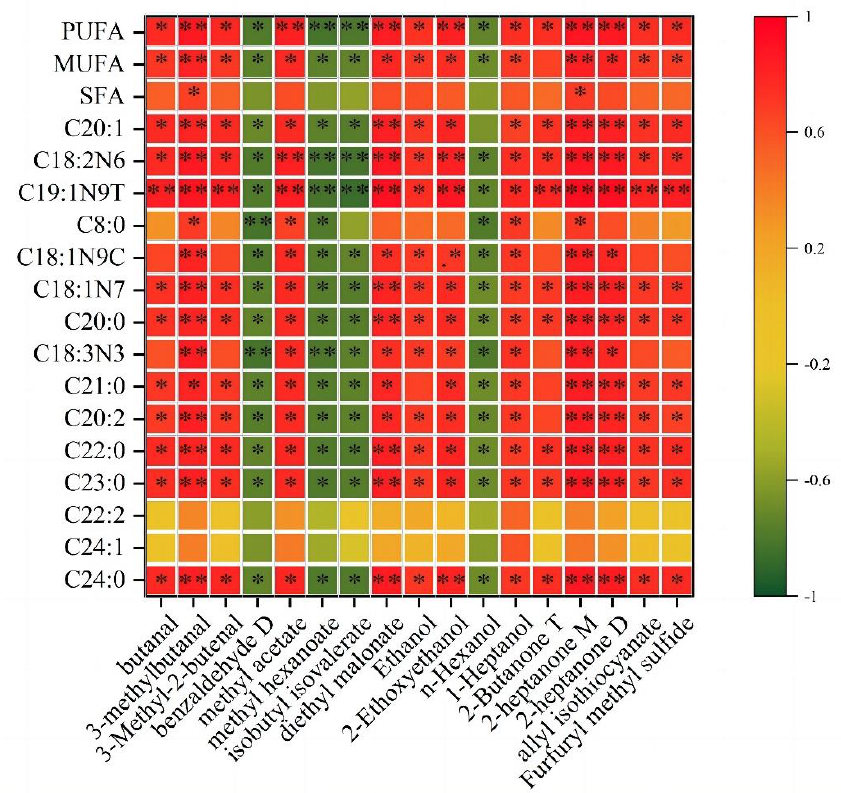
Figure 9. Correlation heat map between fatty acids and volatile flavor substances in heat processing BTS meat